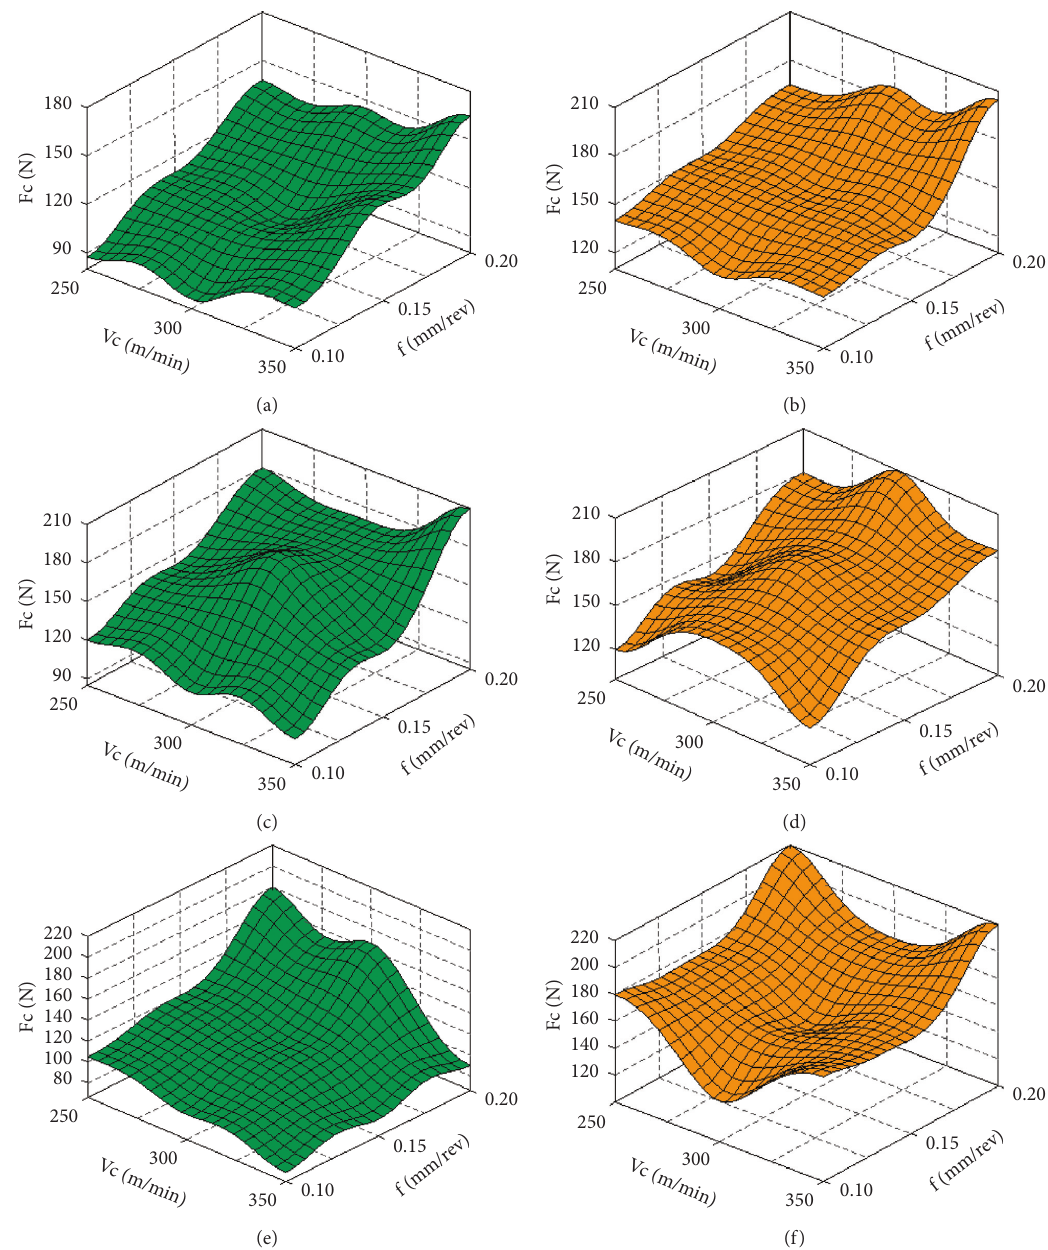
Figure 4: Effects of machining parameters on Fc. (a) Uncoated insert/a � 1mm; (b) TiB2 coated insert/a � 1mm; (c) uncoated